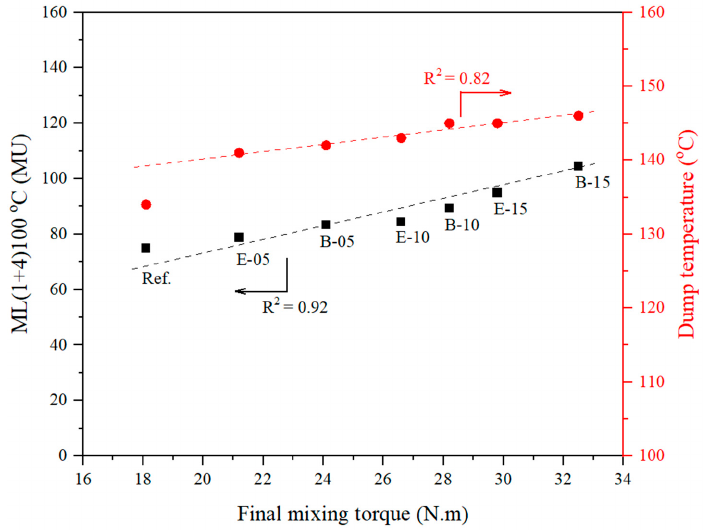
Figure 3. Correlations among final mixing torques, dump temperatures, and Mooney viscosities of silica - filled NR compounds with different amounts of EMZ added via either extra addition (E05– E15) or blending